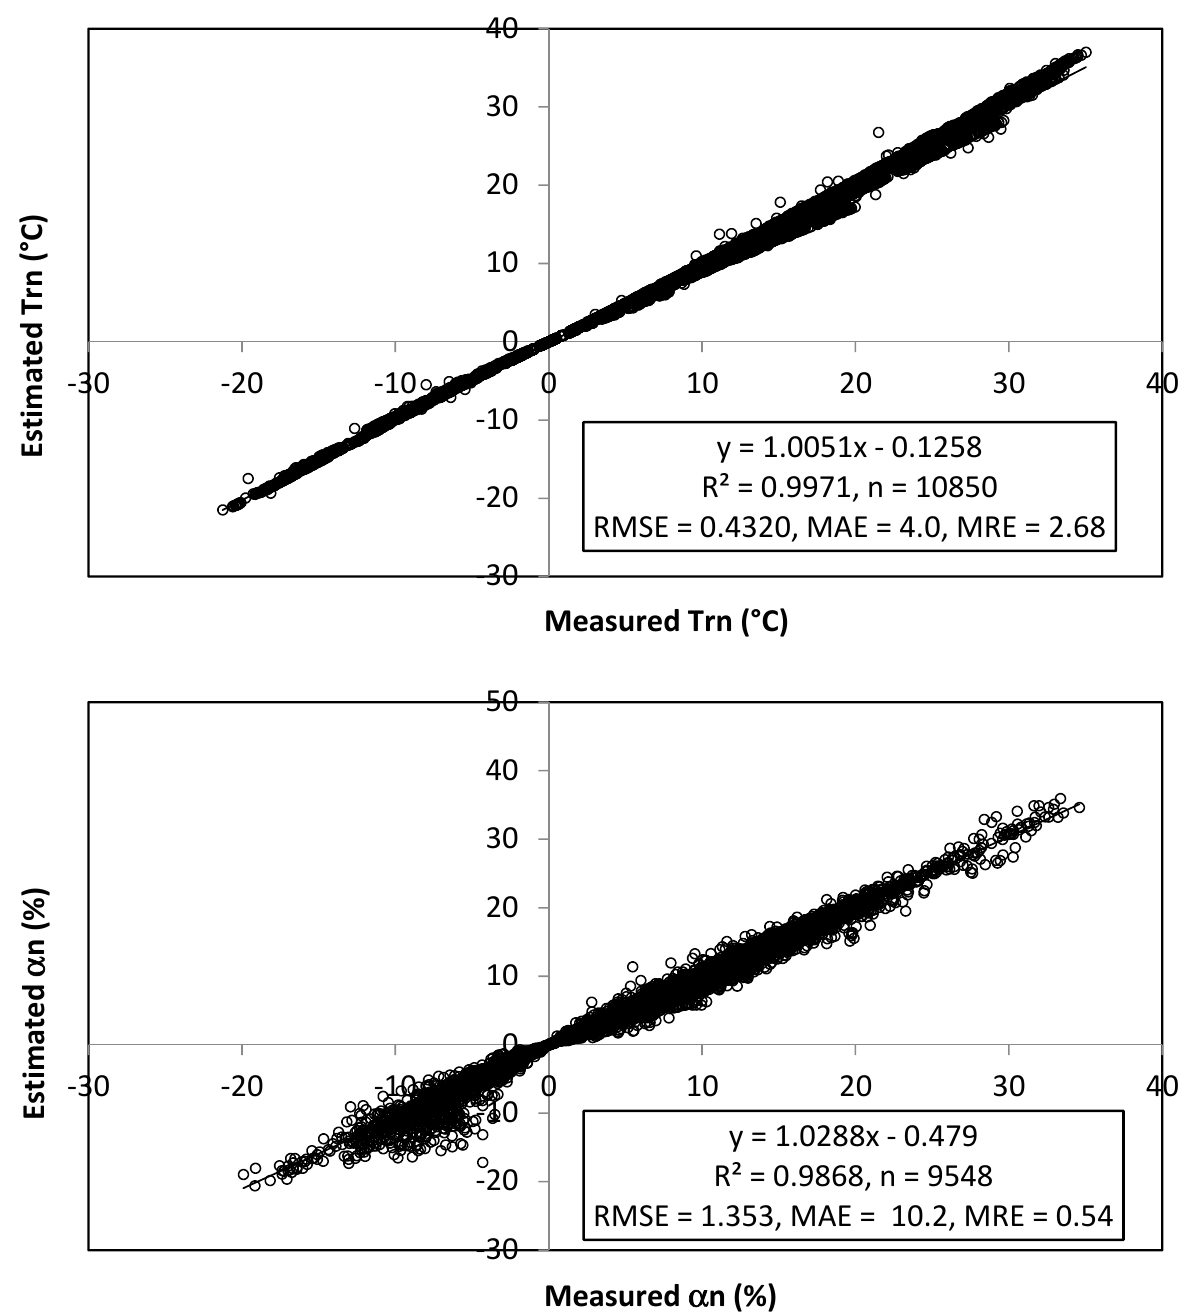
Figure 9. Normalized estimates of radiative temperature and albedo for measurements in all PHs during the measurement campaign with no scale effect.